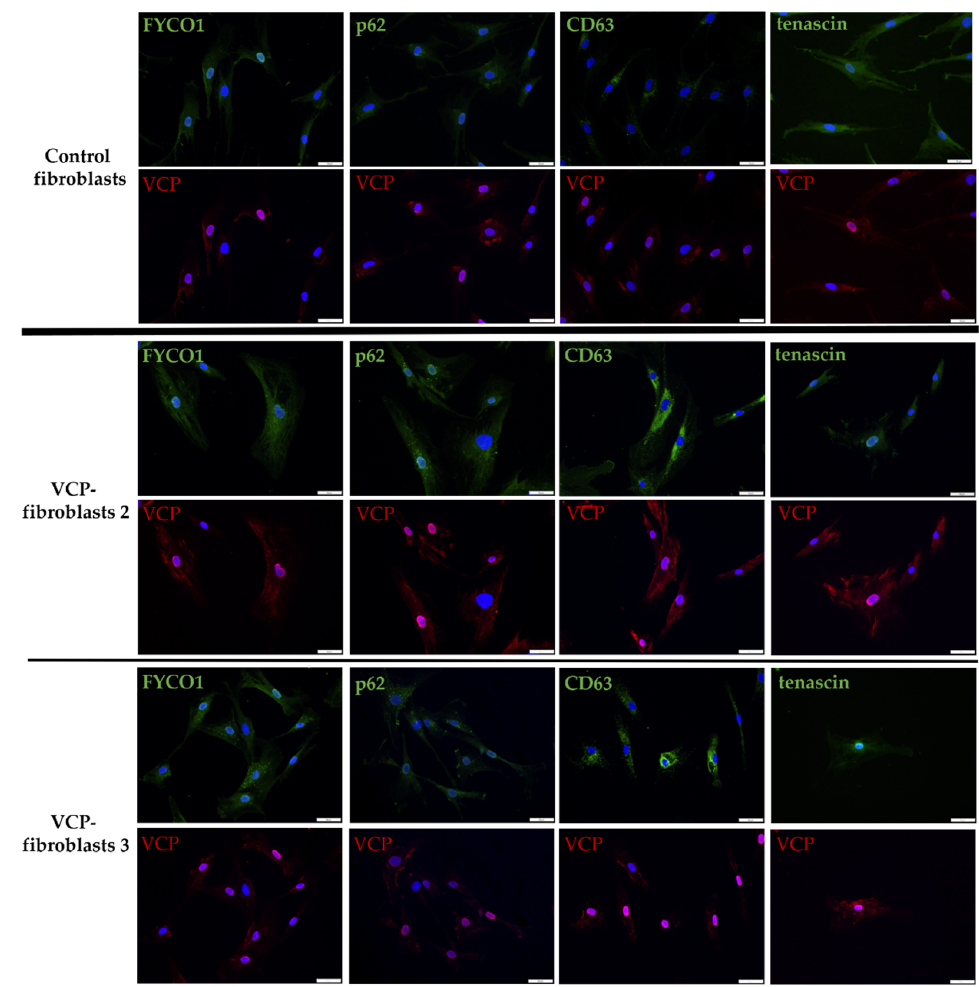
Figure 2 . Immunofluorescence studies on VCP –mutant and control fibroblasts with co–staining of VCP (red) and FYCO1, p62, CD63 and tenascin (green). VCP is increased in the cytoplasm and nuclei of patient derived fibroblasts. CD63 showed a strong cytoplasmic increase in patient fibroblasts compared to controls. FYCO1 and p62 were also more pronounced in patient fibroblasts. Tenascin is reduced in patient–derived fibroblasts. Scale bar = 50 µ m. Two representative patients are shown: VCP fibroblasts 2 = patient 2 and VCP fibroblasts 3 = patient 3; patient numbering is consistent with patient numbering in Figure